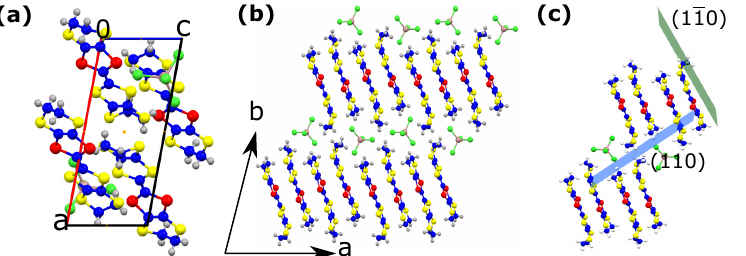
Figure 2. Crystal structure of λ -(BEDT-STF) 2 GaCl 4 . ( a ) The λ -type arrangement of donor molecules within the highly conducting ac -plane. ( b ) The layered structure becomes obvious when looking along the c -direction, where the alternation of donor and anion layers are seen. ( c ) Green and blue planes correspond to ( 110 ) and ( 1¯10 ) ,